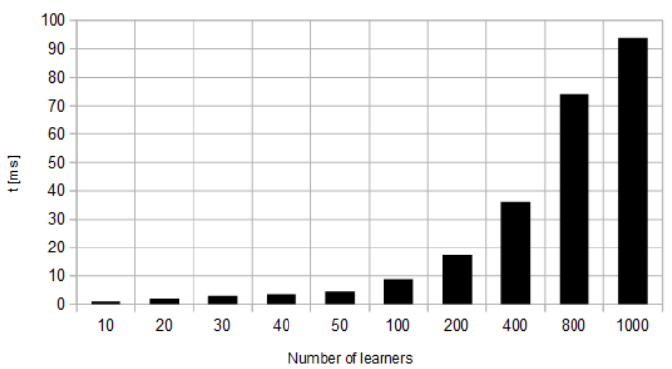
Figure 4. Response time for Ens Bag classifier for different number of learners.